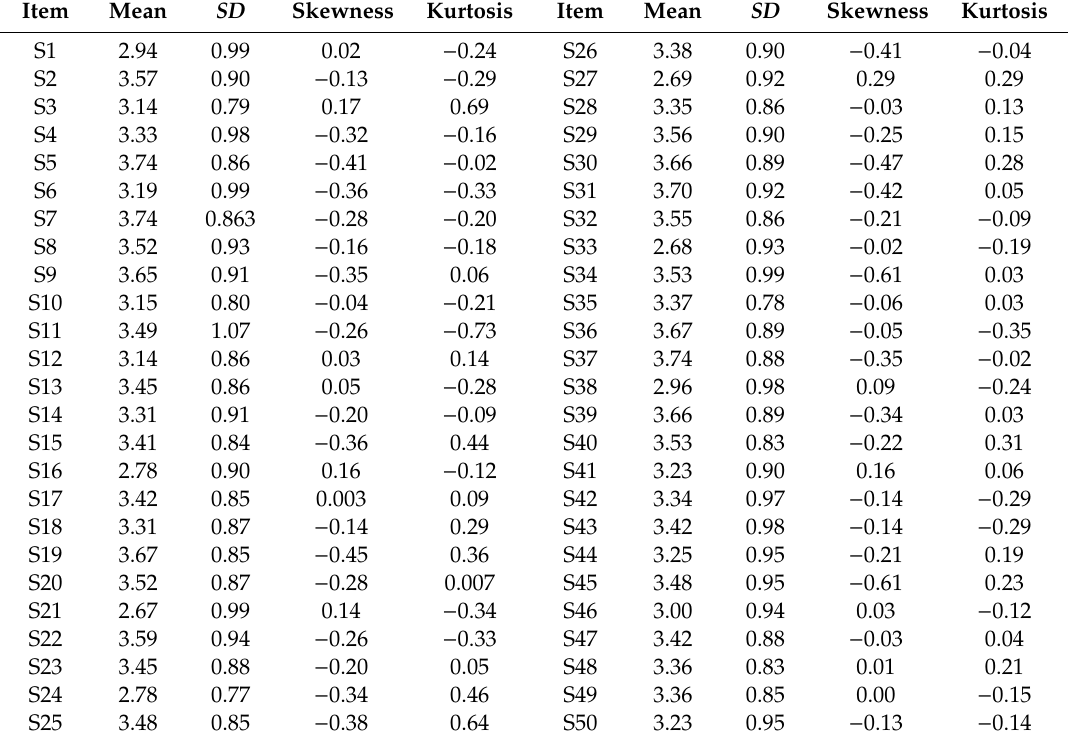
Table 2. Descriptive statistics, skewness, and kurtosis for the Malay language version of the Sports Courage Scale (SCS-M) 50